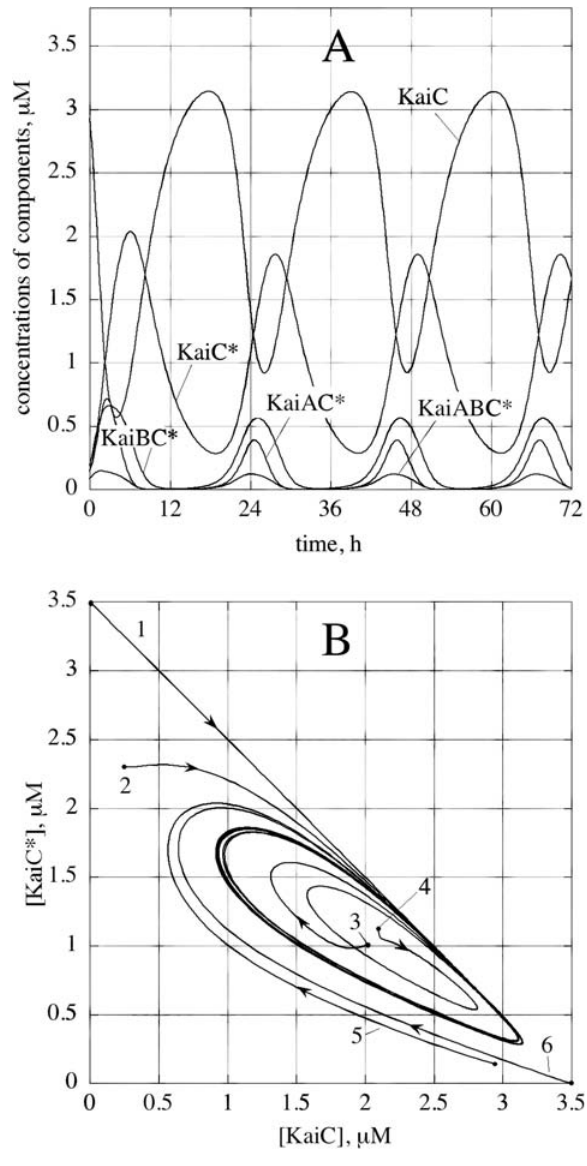
Figure 2. Limit Cycle Oscillations The rate constant values are: k 1 ¼ 1 3 10 (cid:1) 4 l M (cid:1) 1 h (cid:1) 1 , k 2 ¼ 0.4 h (cid:1) 1 , k 3 ¼ 0.45 l M (cid:1) 2 h (cid:1) 1 , k 4 ¼ 3.65 l M (cid:1) 1 h (cid:1) 1 , k 5 ¼ 4.0 h (cid:1) 1 , k 6 ¼ 0.9 h (cid:1) 1 , and k 7 ¼ 0.18 h (cid:1) 1 . (A) Unphosphorylated KaiC and phosphorylated KaiC (KaiC*) oscillate with the largest amplitudes. Oscillations of free unbound KaiA and KaiB concentrations are not shown, but they have amplitudes similar to the KaiBC* oscillations and peak at approximately the same phase as KaiC. (B) Six different approaches to the limit cycle, each obeying mass balances in total KaiA, total KaiB, and total KaiC, i.e., [KaiA] tot ¼ [KaiA] þ [KaiAC] þ [KaiAC*] þ [KaiABC*] ¼ 3 l M, [KaiB] tot ¼ [KaiB] þ [KaiABC*] þ